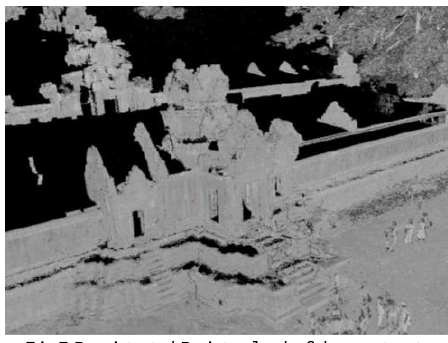
Fig.7 Registrated Points cloud of the east gate